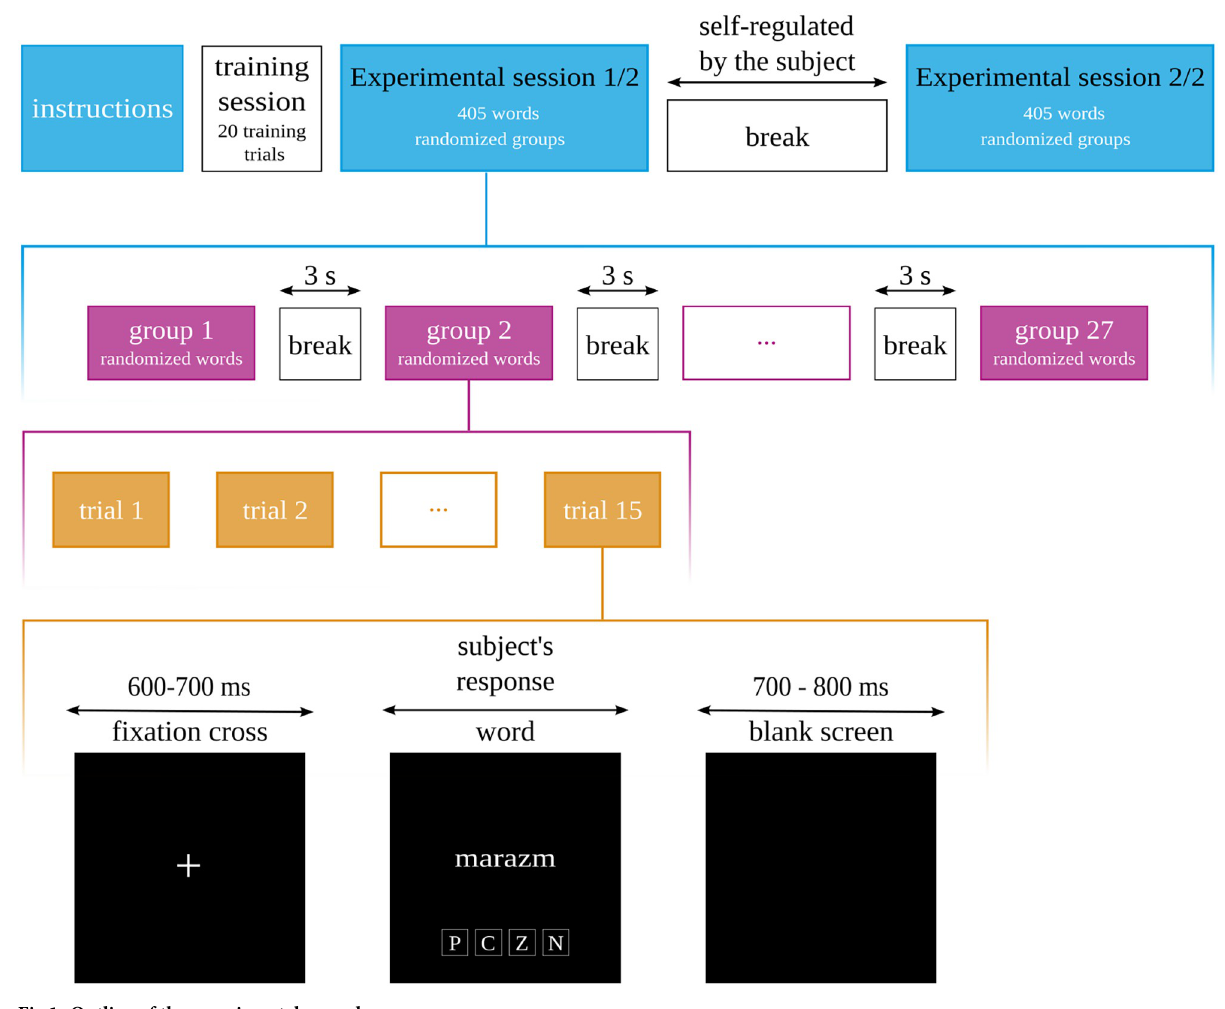
Fig 1. Outline of the experimental